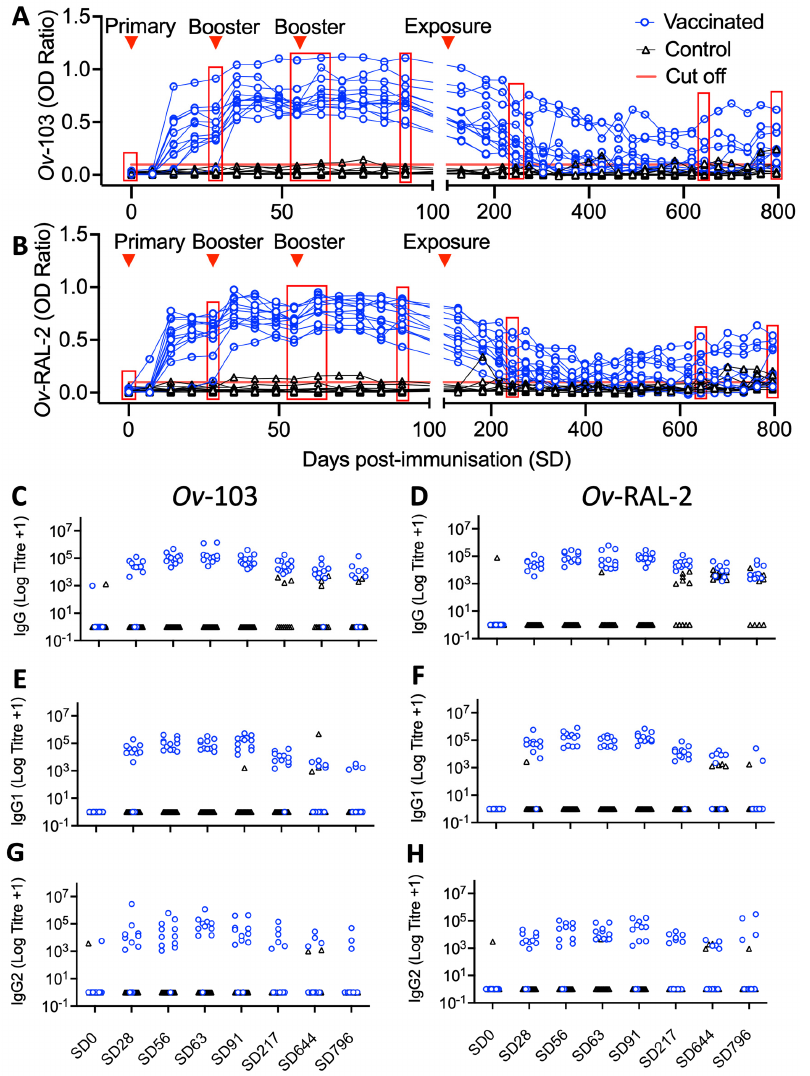
Figure 4. Timeseries of ( A ) anti- Ov -103 and ( B ) anti- Ov -RAL-2-specific serum IgG responses for vaccine efficacy trial animals by ELISA (1:800 dilution). Relative timing of primary, booster immuni- sations and natural exposure are denoted. Solid red line denotes each assay’s detection threshold for serum IgG. Highlighted timepoints (red boxes) denote those taken for IgG and isotype end-point serum antibody titrations ( C – H ), namely pre-immunisation (SD0), 4 weeks post primary immuniza- tion (SD28), 4 weeks post first booster immunization (SD56), 1 week post second booster immu- nization (SD63), 1 week pre-natural exposure (SD91), 4 months post-exposure (SD217), 18 months post-exposure (SD644), Final sampling